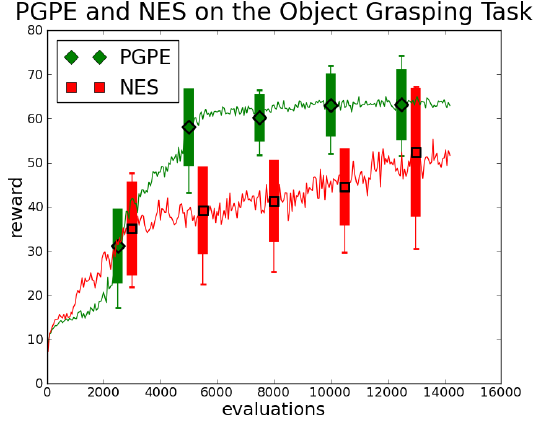
Figure 6. REINFORCE on the pole balancing task, with various action pertur- bation probabilities (1, 0.5, 0.25, 0.125). PGPE is shown for refer- ence.